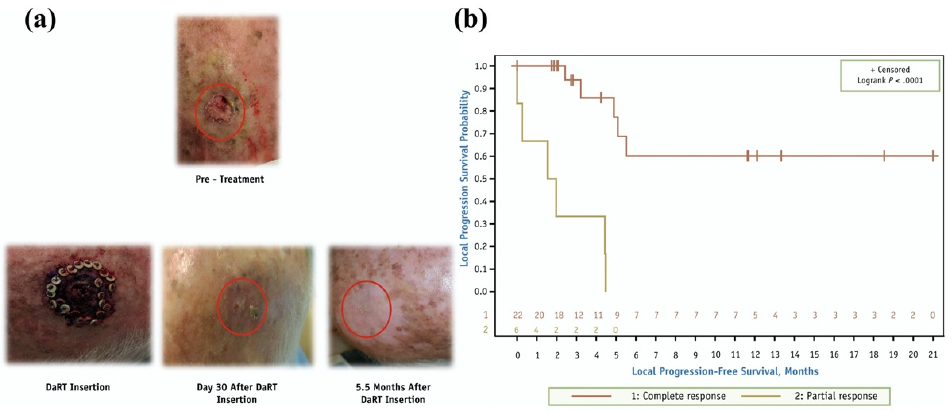
Figure 9. ( a ) Deeply infiltrating squamous cell carcinoma of the scalp showing complete response to diffusing alpha emitters therapy (DaRT) by day 30. ( b ) Kaplan-Meier local progression-free survival stratified by complete and partial response [94]. Reproduced with permission from Popovtzer, A., published by Elsevier, 2020